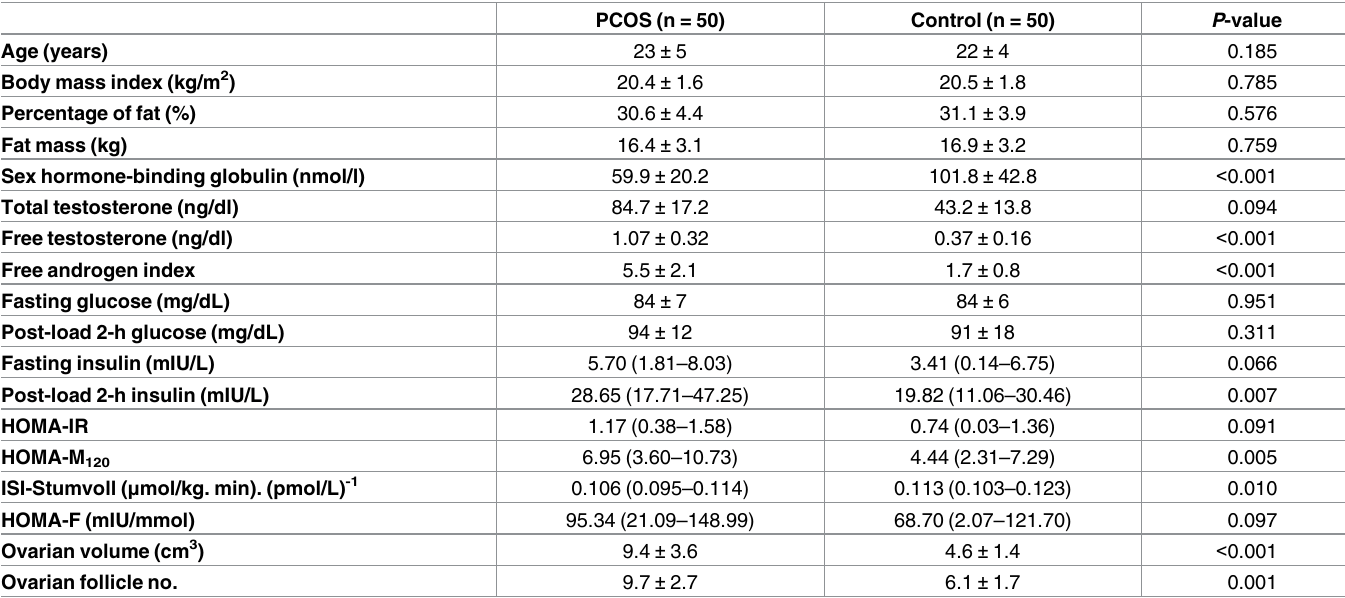
Table 2. Clinical and biochemical characteristics in lean